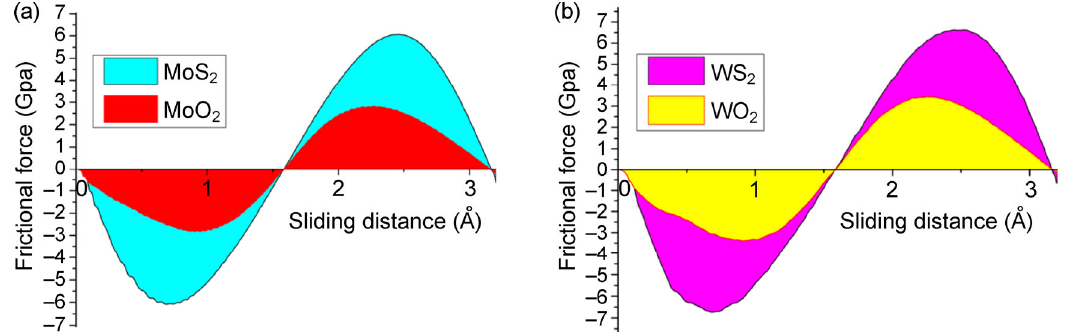
Fig. 6 Interlayer friction work done by (a) MoS 2 and MoO 2 , and (b) WS 2 and WO 2 , during friction in a commensurate condition. Table 2 Mechanical properties of bulk MoO 2 , MoS 2 , WO 2 , and WS 2 .